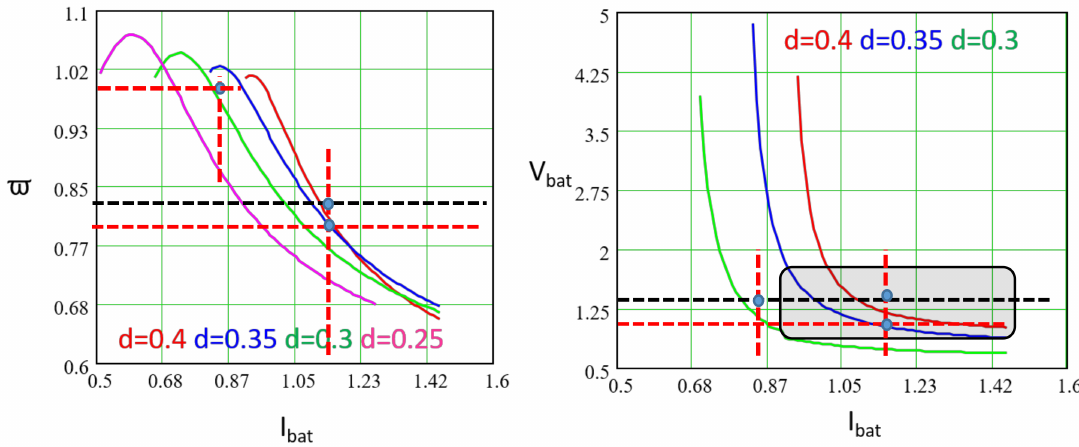
Figure 8. Power topology normalized plots: all the magnitudes are referred to the primary side, according to the simplified circuits. The preferred operation area and a possible trajectory are also